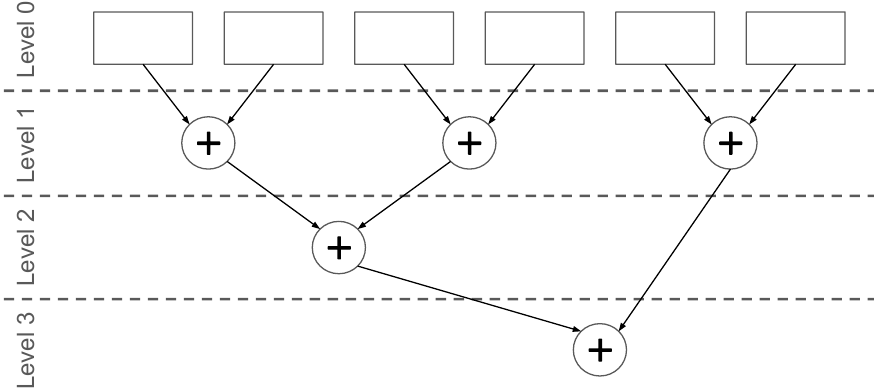
Figure 9. Summation scheme in linear